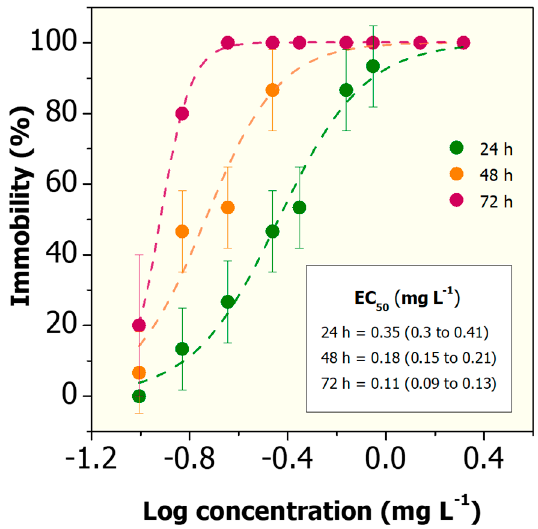
Figure 5. Acute toxicity of Cd 2+ on D. magna after 24, 48, and 72 h of exposure in reconstituted water. PriProbit software was used to obtain the EC 50 values via Probit analysis including 95% confidence limits.